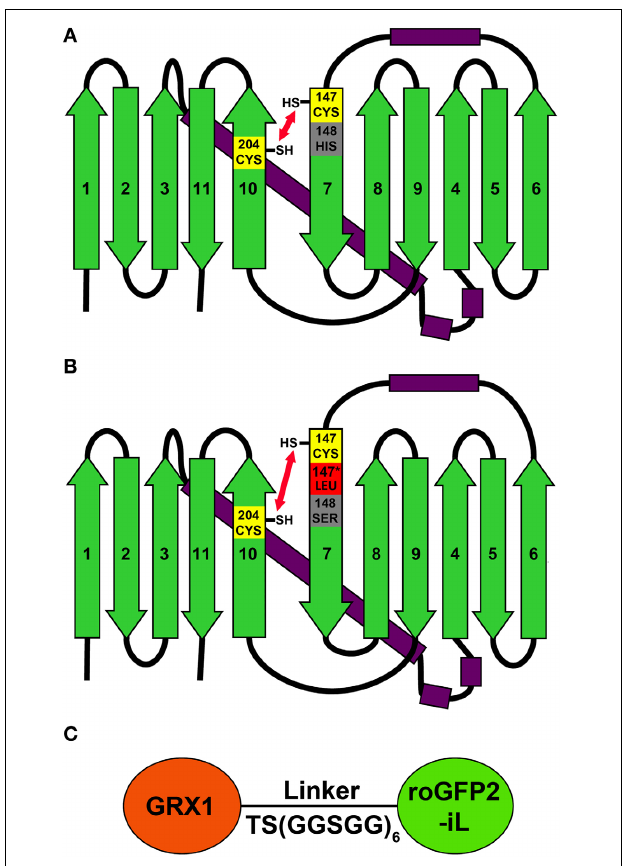
FIGURE 1 | 2D models of roGFP2 and roGFP2-iL illustrate the relative position of disulfide forming Cys147 and Cys204. (A) Cys147 and Cys204 are located on strands 7 and 10, respectively, and are positioned in close proximity so that they can facilitate disulfide formation. (B) The introduction of a leucine next to Cys147 (Leu147*) and the substitution of His148 by serine increase the relative distance between Cys147 and Cys204 that causes alterations in the thermodynamic stability of the disulfide. (C) Schematic representation of the GRX1-roGFP2-iL fusion protein. GRX1 was fused to the N-terminus of roGFP2-iL by a TS(GGSGG) 6 linker.